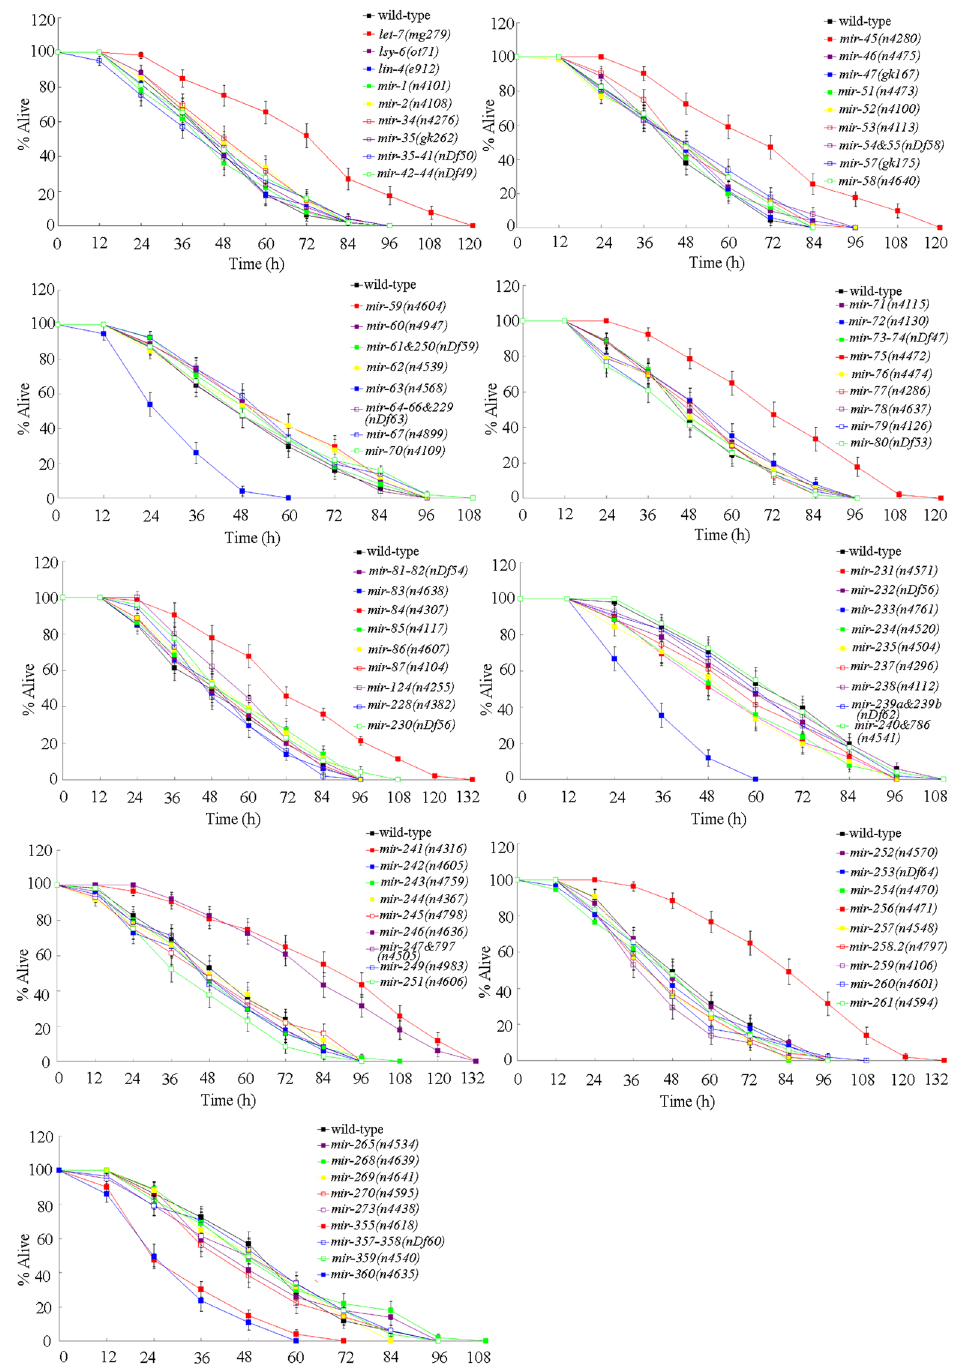
Figure 1. Survival in miRNA mutants infected with P. aeruginosa PA14. Bars represent mean ±